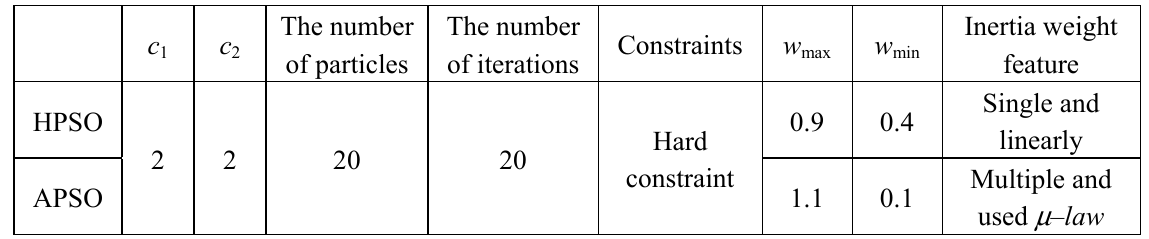
Table 2. Selected PSO